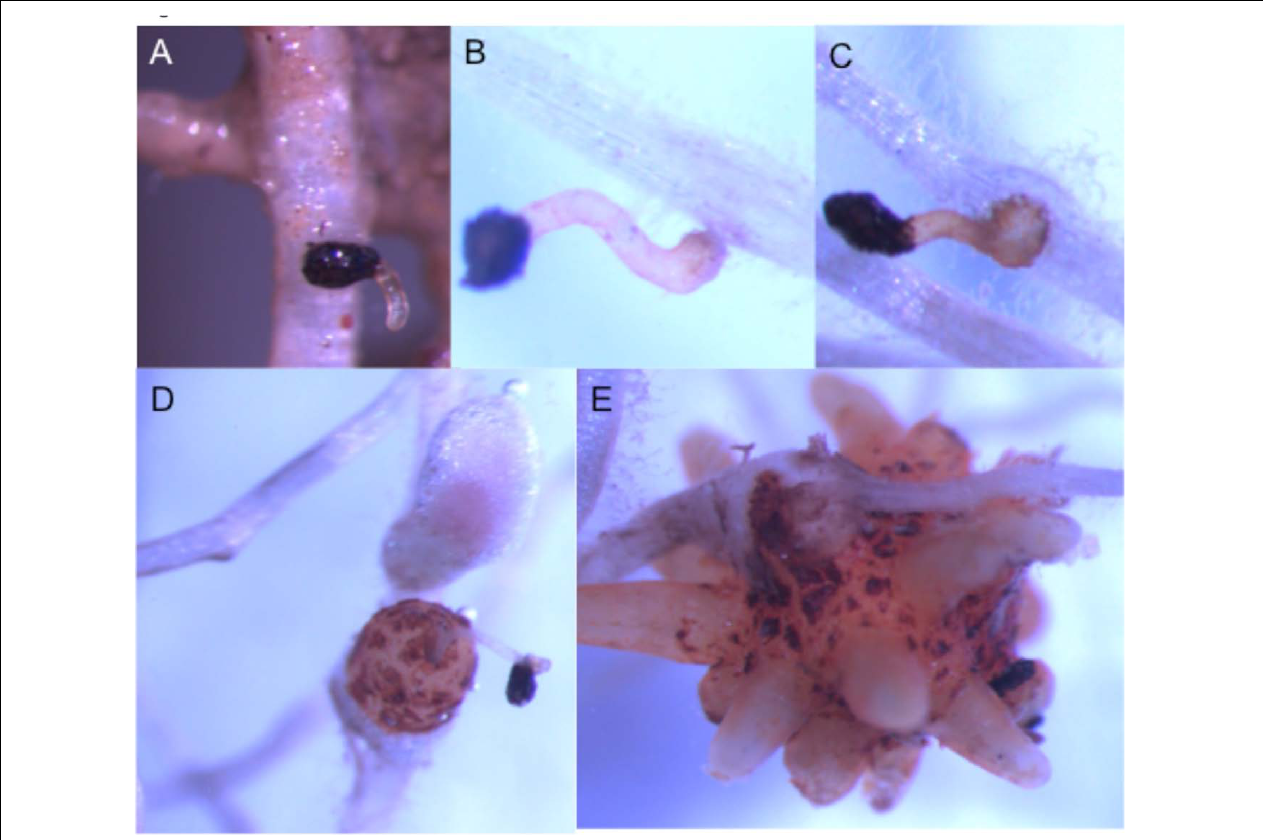
FIGURE 1 | Orobanche minor seedlings at successive stages of the infection of clover roots observed during a field trial in Burgundy, France. (A) O. minor germination. (B) O. minor adhesion to host root. (C) Host penetration. (D) Vascular connection. (E) Tubercle development with initiation of ‘spider’ stage.